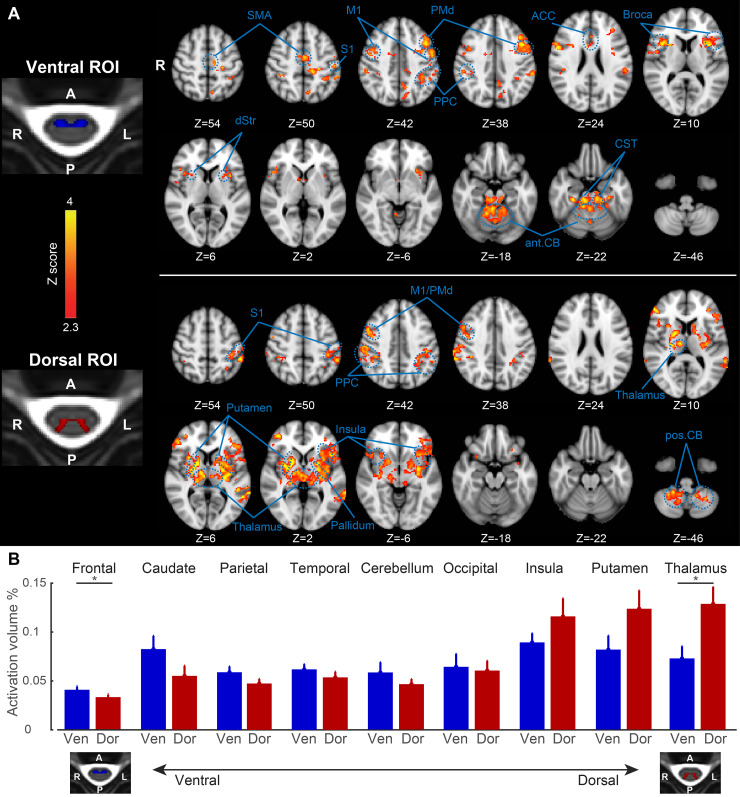
Distinct resting-state brain connectivity associated with the ventral and dorsal horns of the spinal cord.(A) The ventral horn (top row) is significantly correlated with bilateral M1, dorsal premotor cortex, supplementary motor area, anterior cingulate cortex, Broca’s area, S1, posterior parietal cortex, anterior dorsal striatum, anterior cerebellar cortex, and corticospinal tract. On the other hand, the dorsal horn (bottom row) is significantly correlated with bilateral S1, posterior parietal cortex, insula, thalamus, putamen, pallidum, M1, dorsal premotor cortex, and the posterior cerebellum. Color-coded activation maps indicate z-score values, corrected p < 0.05. (B) Key brain areas sorted based on their strength of functional connectivity to the ventral and dorsal horns of the spinal cord. Bar plots show the percent volume of activation related to the ventral (blue bars) and dorsal (red bars) spinal horn in different brain areas. From left to the right, the brain areas are sorted based on their functional connectivity preference to the ventral horn (the most left) or to the dorsal horn (the most right). The percent volume for each brain area is calculated by dividing the active volume (p < 0.01) to the total volume of that area. As shown, the frontal lobe, caudate, and parietal lobe tend to be more synchronised with the ventral horn activation, while the thalamus, putamen, and insula tend to be more synchronised with the dorsal horn activation at rest. The 9 brain areas are defined from the parcellation of brain in the MNI structural atlas. *p < 0.05. The numerical data used in this figure are included in S1 Data. ACC, anterior cingulate cortex; ant.CB, anterior cerebellum; CST, corticospinal tract; Dor, dorsal; dStr, dorsal striatum; MNI, Montreal Neurological Institute; PMd, dorsal premotor cortex; pos.CB, posterior cerebellum; PPC, posterior parietal cortex; SMA, supplementary motor area; Ven, ventral.